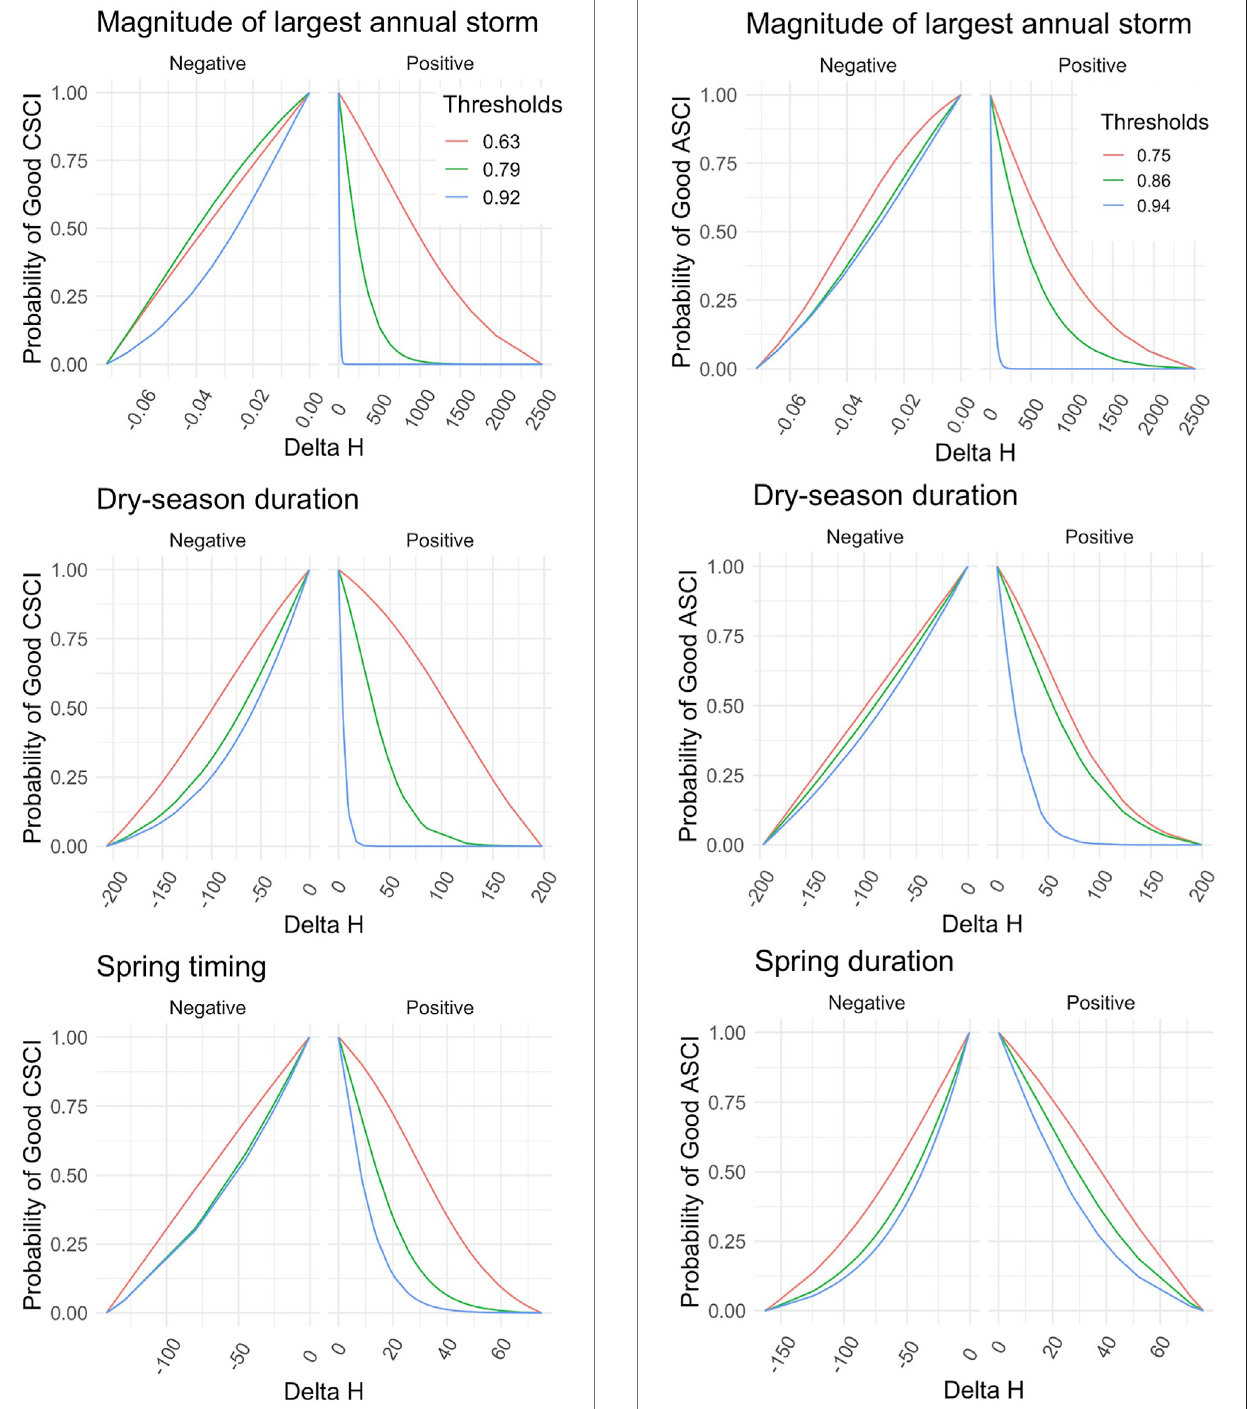
Frontiers in Environmental Science |